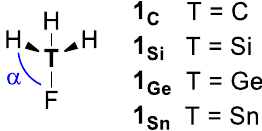
Figure 1. Chosen MOs and electrostatic potential (ESP) maps for 1 C with three different F-C-H angles (α). ESP maps are on the 0.001 density isosurface. The color scale is in kJ mol −1 . σ F-T corresponds to the